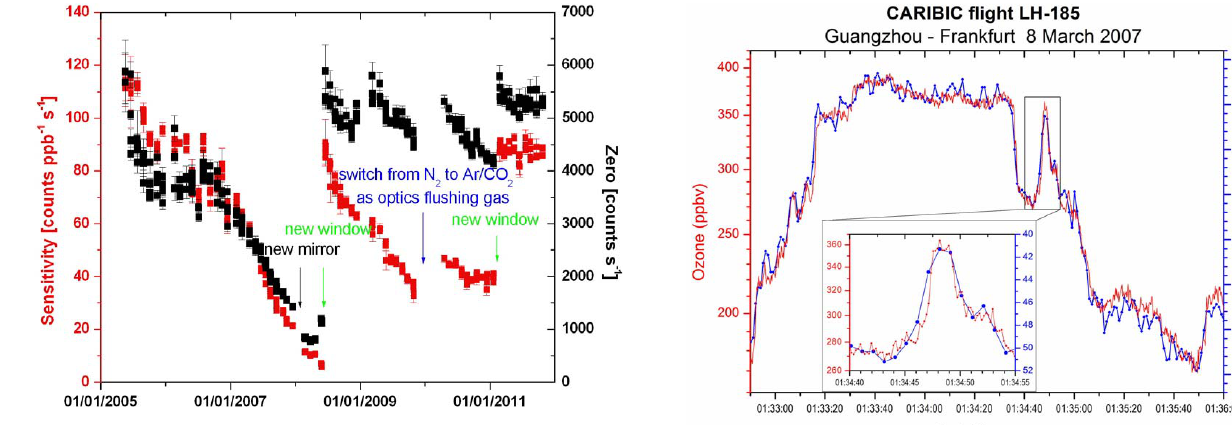
Fig. 3. Long-term progression of the zero signal and the sensitivity during the use onboard the CARIBIC aircraft. The points represent the averages over the duration of each flight (typically of 9–12h) and the error bars their standard deviation. Instrument maintenance (see text): (1) replacement of the off-axis parabolic mirror (February 2008), (2) replacement of the MgF 2 lamp window (June 2008 and February 2011), (3) switch from N 2 to Ar/CO 2 (December 2009) as a flushing gas for the optics.